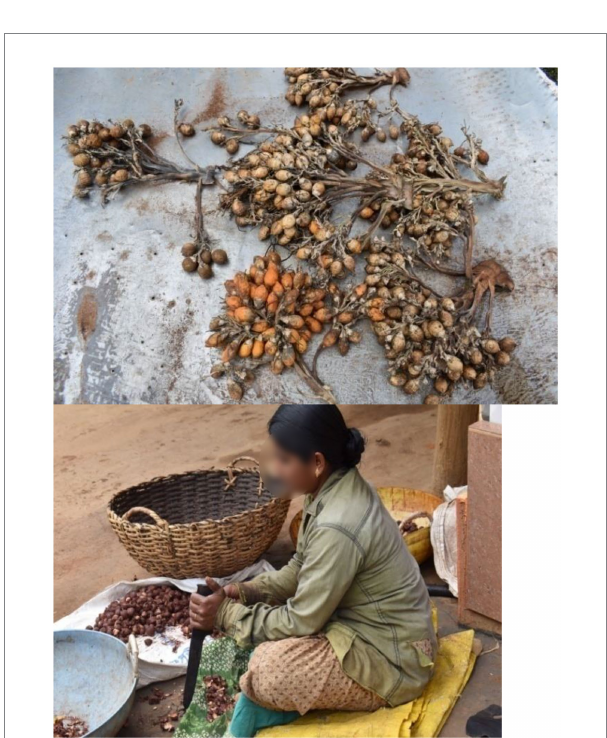
FIGURE 3 Field photos: segregation of Areca nut and the lady processing them (courtesy: the lead